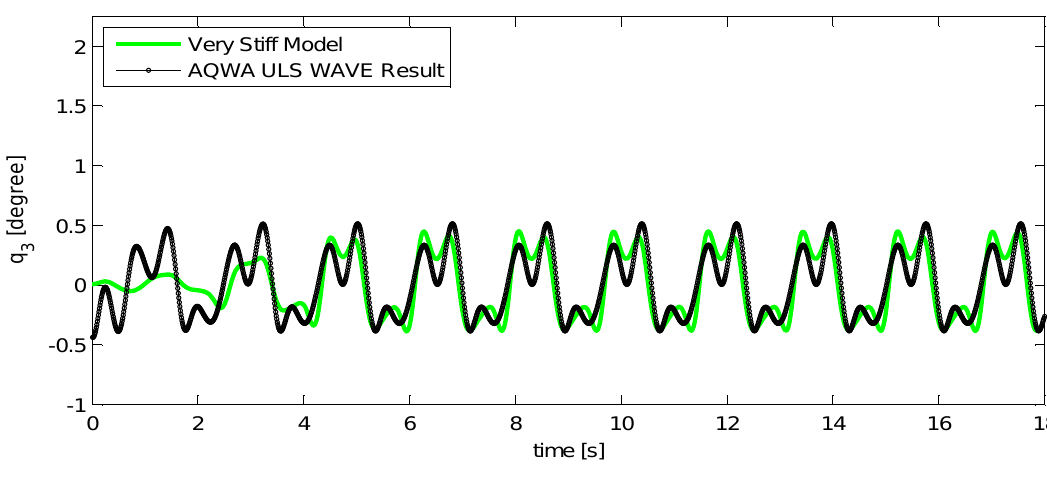
Figure 6. Code-to-code comparison between the hybrid model, including quasi-rigid topside layout pitch response and ANSYS AQWA pitch response under regular wave load